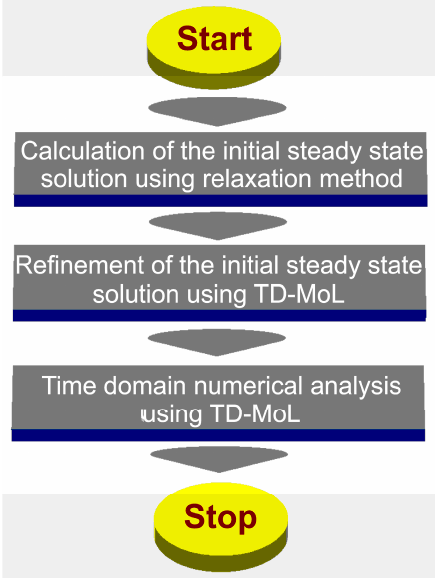
Figure 4. Flowchart showing the sequence followed during numerical calculations.